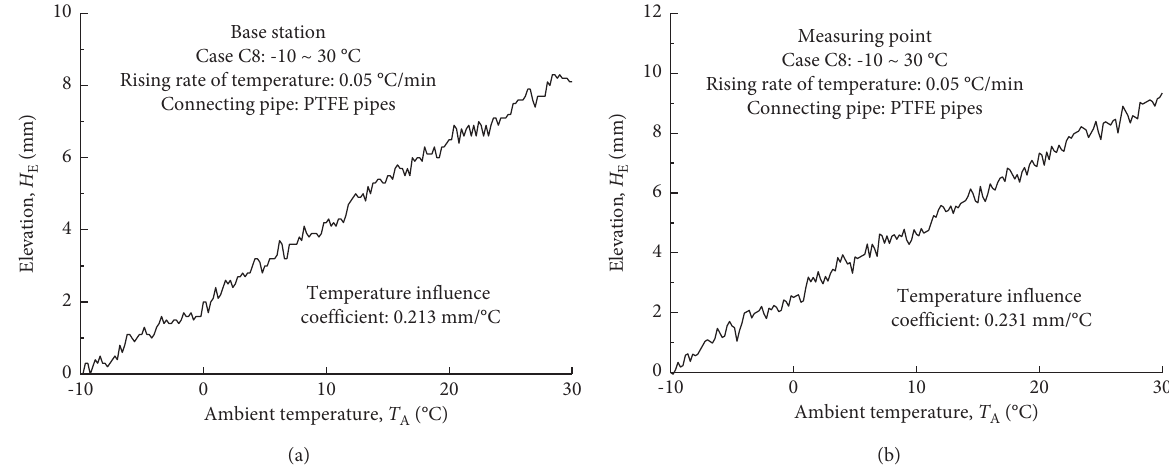
Figure 7: The relationship between ambient temperature and elevation of the base station and test point HSL for case C8. (a) Base station. (b) Measuring